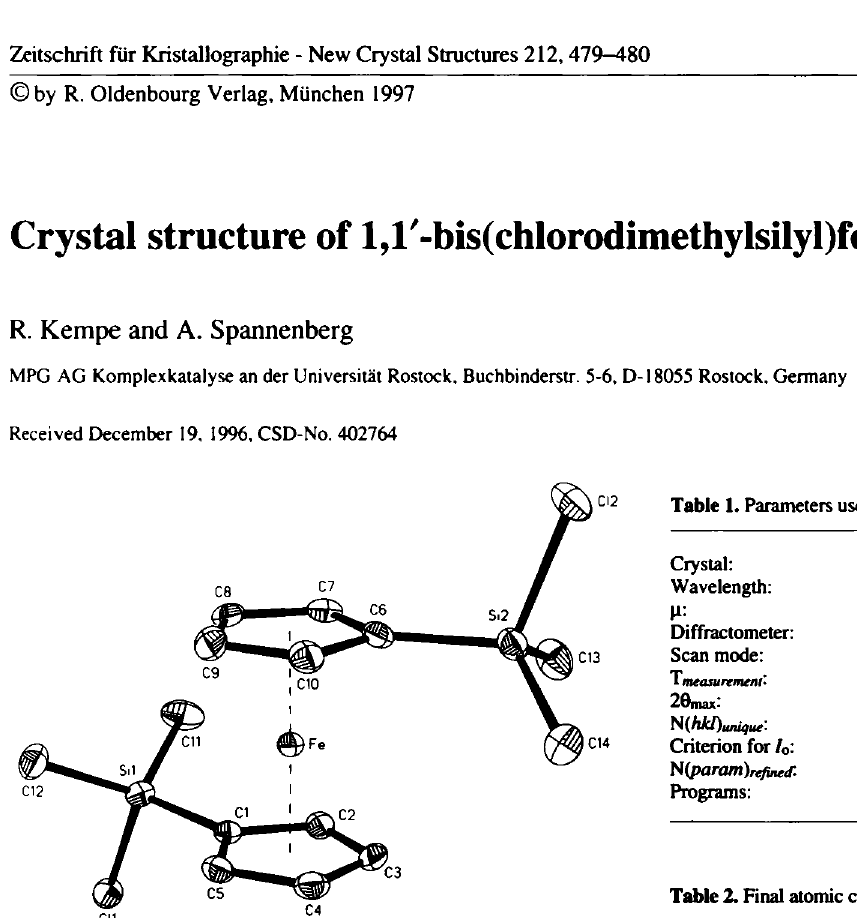
Table 2. Final atomic coordinates and displacement parameters (in Â 2 )